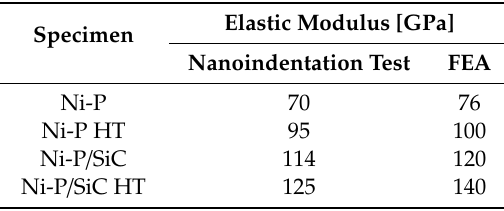
Table 1. Comparison of the elastic moduli of the nanocomposite coatings calculated from nanoindentation experiments and Finite Element Analysis (FEA) determined estimates.